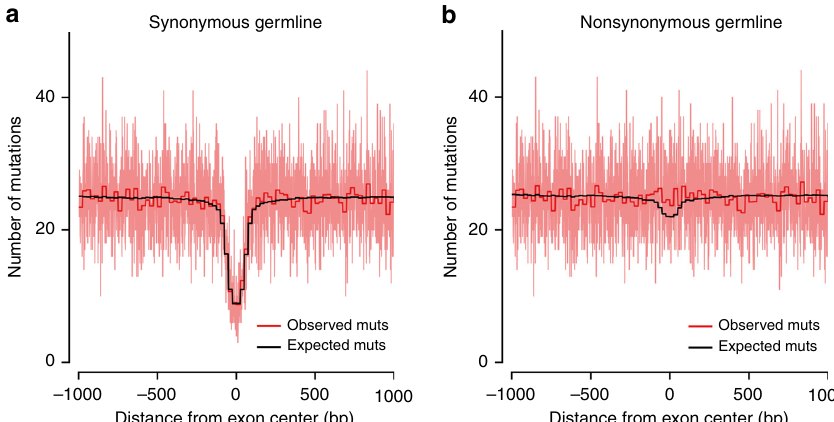
Fig. 2 Internal exon-centered analysis for synonymous and nonsynonymous DNMs. The light red line represents the observed number of mutations at each nucleotide position, while the dark red and black lines represent averages in bins of size 25 positions for observed and expected mutations, respectively. a Synonymous DNM pro fi le with observed exonic mutation difference of − 1.1% ( P = 0.353). b Nonsynonymous DNM pro fi le, showing an exonic excess of 10.4% ( P = 0.001). Due to the removal of nonsynonymous and synonymous mutations in panels ( a ) and ( b ), respectively, the total number of exonic mutations relative to fl anking introns is reduced. The number of mutations, when moving away from the center, converges to that of Fig. 1b.